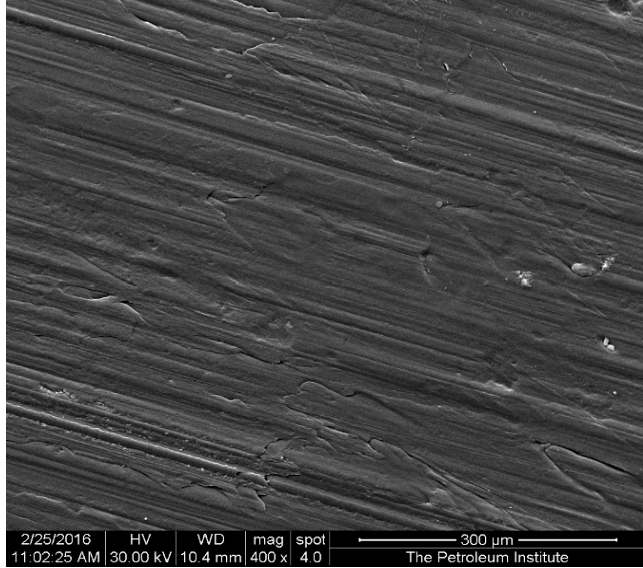
Figure 1. Representative secondary electron (SE) scanning electron microscopy (SEM) micrograph of high density polyethylene (HDPE)/TiO 2 composites with 5 wt % nano-TiO 2 prepared at a barrel temperature of 225 °C for 50 min of residence time. Image taken at 400× magnification and scaled to 300 micrometers.